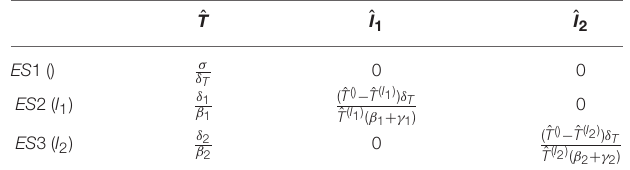
TABLE 4 | Equilibrium states in the case of bystander killing of uninfected cells without immune